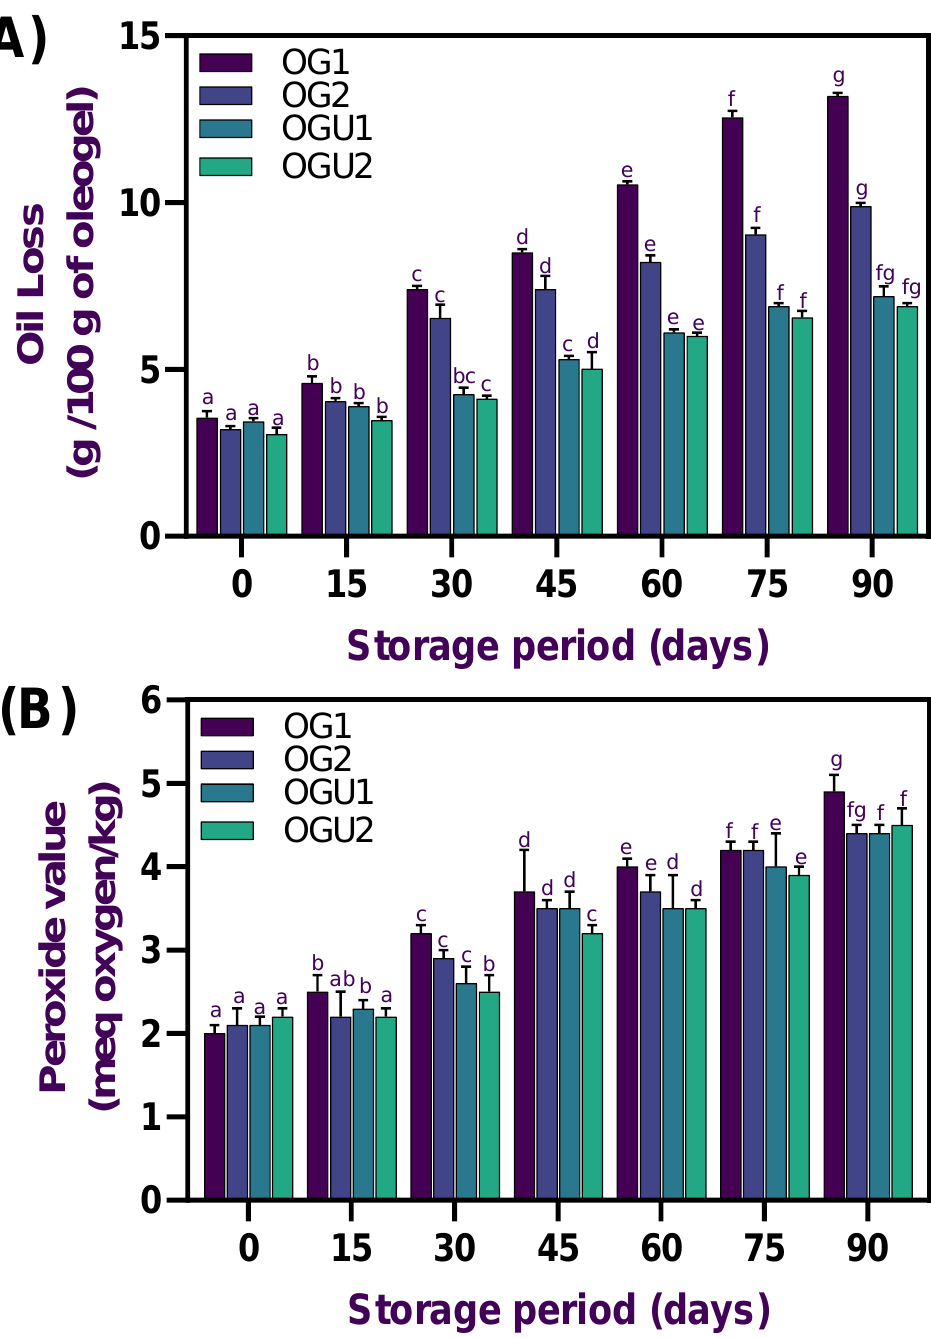
Figure 7. Oil loss ( A ) and peroxide value ( B ) of palm oil-based oleogels prepared with different concentrations of carnauba wax and the ultrasonication process.